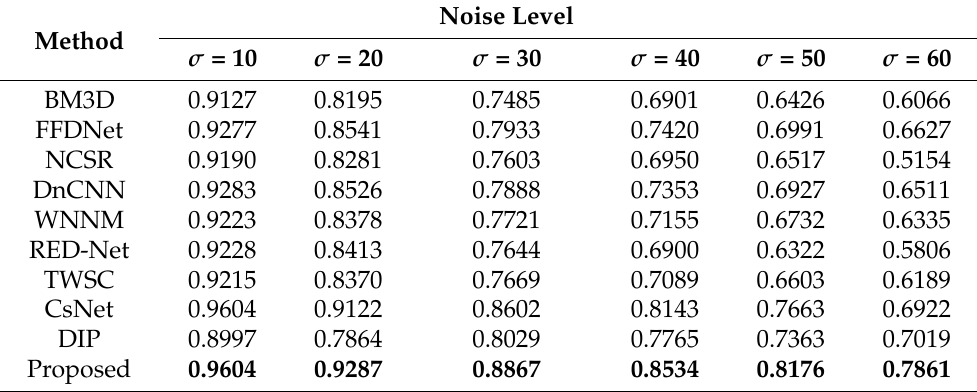
Table 13. Average SSIM results of different methods on 10 images in Flickr1024 with various noise levels.